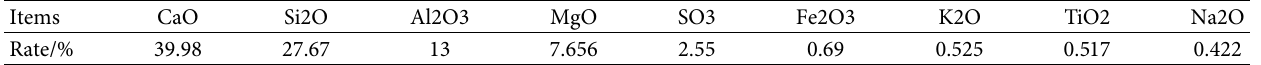
Table 4: Main Compositions of Special Curing agent.